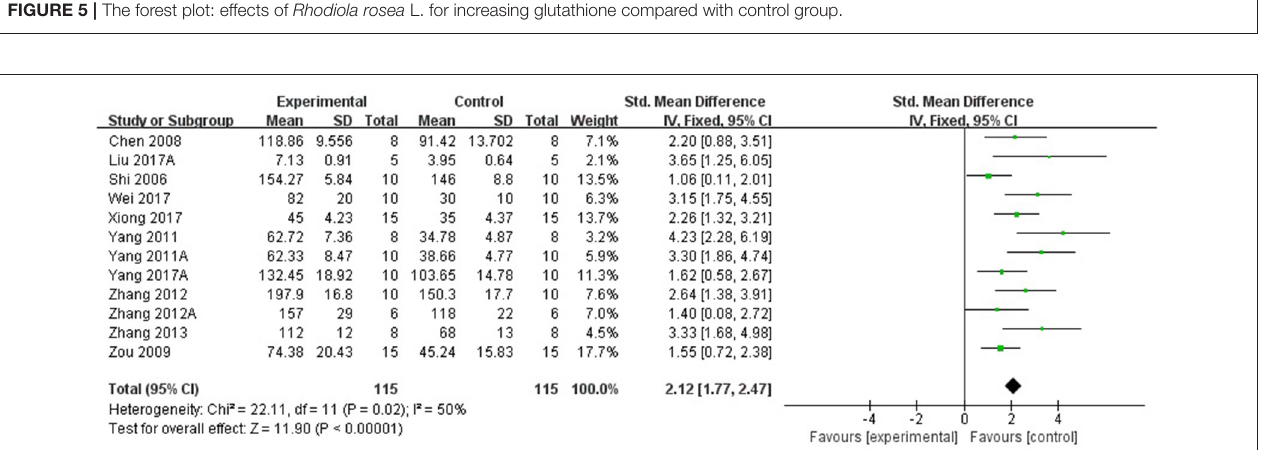
FIGURE 5 | The forest plot: effects of Rhodiola rosea L. for increasing glutathione compared with control group.